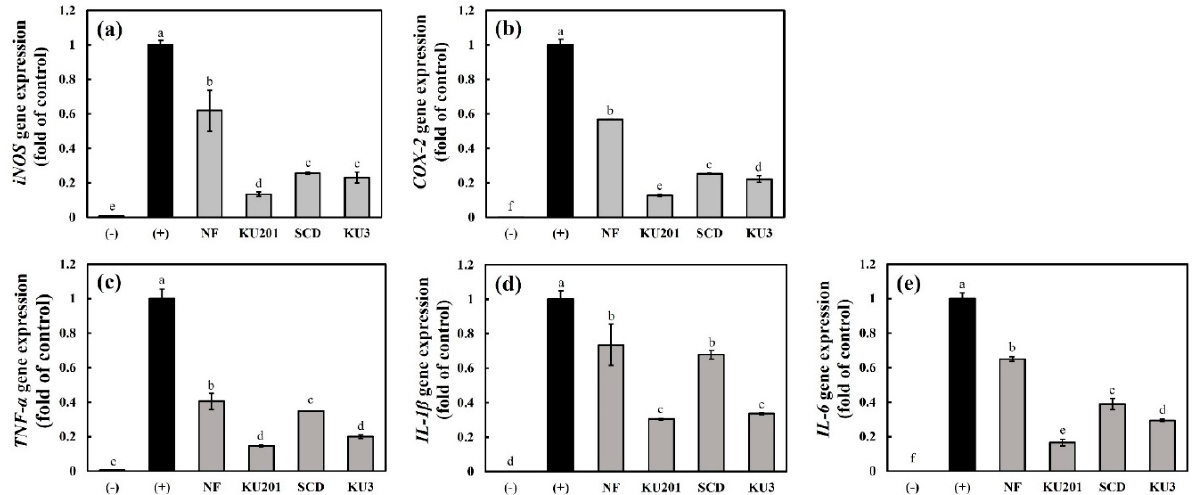
Figure 3. Relative gene expression levels of inflammation mediators in RAW 264.7 cells: ( a ) inducible nitric oxide synthase (iNOS) ; ( b ) cyclooxygenase-2 (COX-2) ; ( c ) tumor necrosis factor (TNF)- α ; ( d ) interleukin (IL)-1 β ; ( e ) interleukin IL-6 . ( − ): negative control without lipopolysaccharide (LPS); (+): positive control with LPS; NF: nonfermented hydroponic ginseng (HG); KU201: HG fermented with B. subtilis KU201; SCD: HG fermented with B. polyfermenticus SCD; KU3: HG fermented with B. polyfermenticus KU3. The data are represented as means ± standard deviations of triplicates. Statistical differences ( p < 0.05) are represented with different letters above error